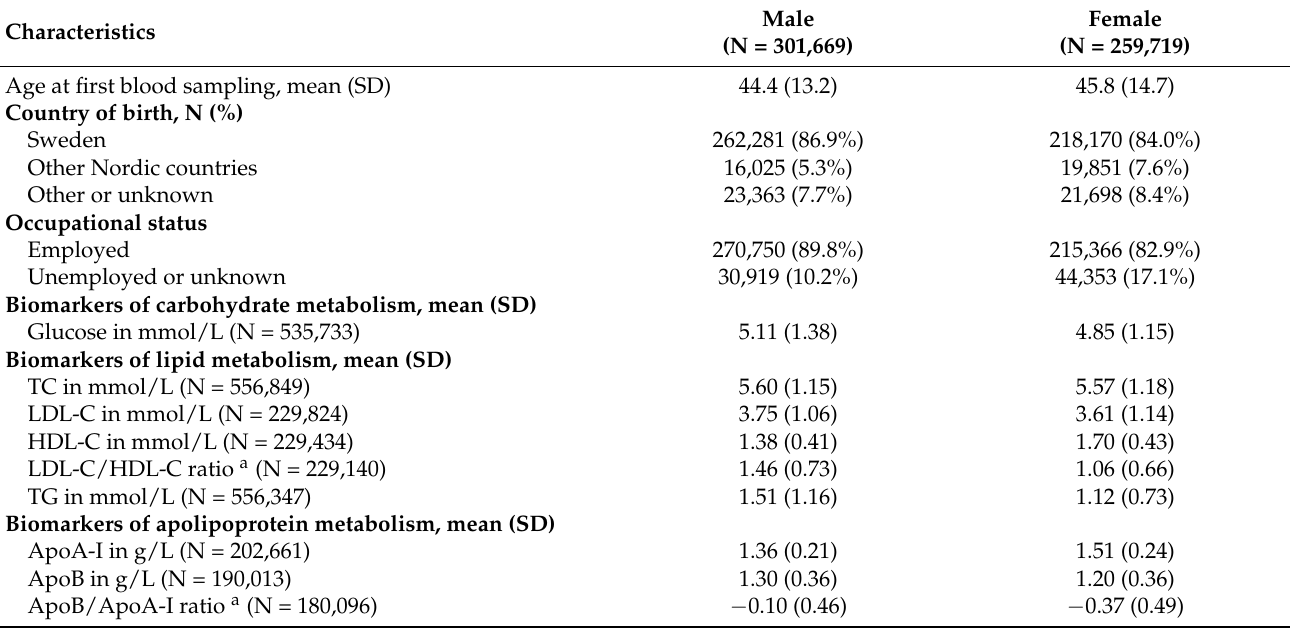
Table 2. Baseline characteristics of the cohort participants.